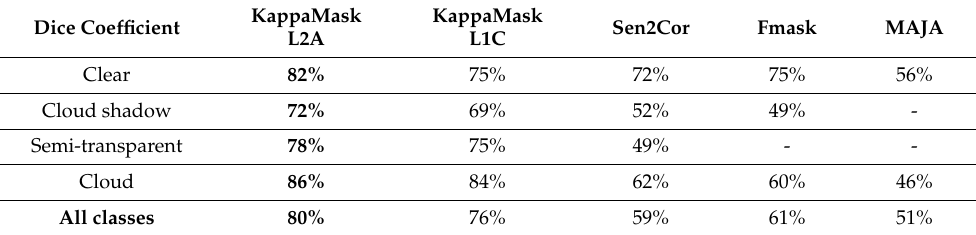
Figure 7. Comparison of L1C prediction output for a 512 × 512 pixels sub-tile in the test dataset. ( a ) Original Sentinel-2 L1C True-Colour Image; ( b ) KappaMask classification map; ( c ) Segmentation mask prepared by a human labeller; ( d ) Fmask classification map. Table 2. Dice coefficient evaluation performed on the test dataset for KappaMask Level-2A, Kappa- Mask Level-1C, Sen2Cor, Fmask and MAJA cloud classification maps. Evaluation is performed for clear, cloud shadow, semi-transparent and cloud classes.